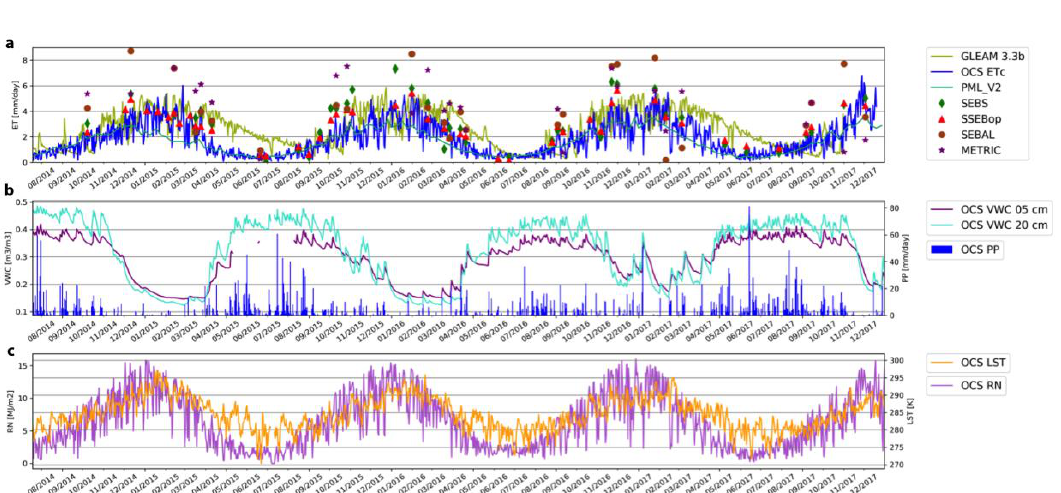
Figure 4. Comparison of evapotranspiration maps for pastures during summer days produced by each Figure 4. Evapotranspiration estimates and daily surface meteorology at the Oromo calibration site (OCS) between August 2014 and December 2017. ( a ) Comparison of satellite-based and measured model (SEBS, SSEBop, SEBAL, METRIC). ( a ) 13 February 2015. ( b ) 31 January 2016. ( c ) 6 March daily evapotranspiration. Measured ET c in Oromo (blue line) is compared with estimates by SEB models (points) and GLEAM 3.3b (yellow line), and PML_V2 (turquoise line) products for the nearest pixel to the station. ( b ) Daily rainfall (blue bars) and soil moisture (purple, turquoise lines) in Oromo. ( c ) Net daily radiation (purple) and surface temperature (orange) measured in Oromo.